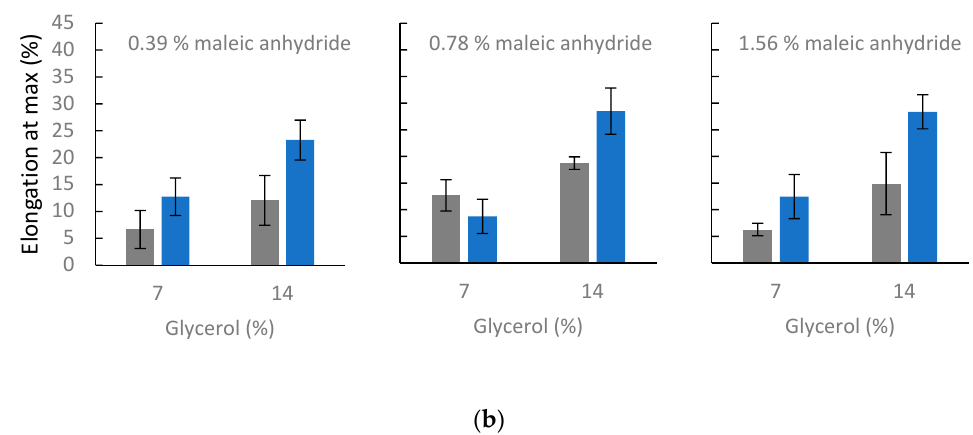
Figure 6. Mean values of tensile strength ( a ) and elongation at max ( b ) of films from the optimization experiment for different maleic anhydride levels. The X-axis represents the concentrations (%) of glycerol (7 and 14); and the grey and blue colors represent 7 and 14 % sugar levels, respectively, used in the films. Individual standard deviations were used to calculate the intervals.